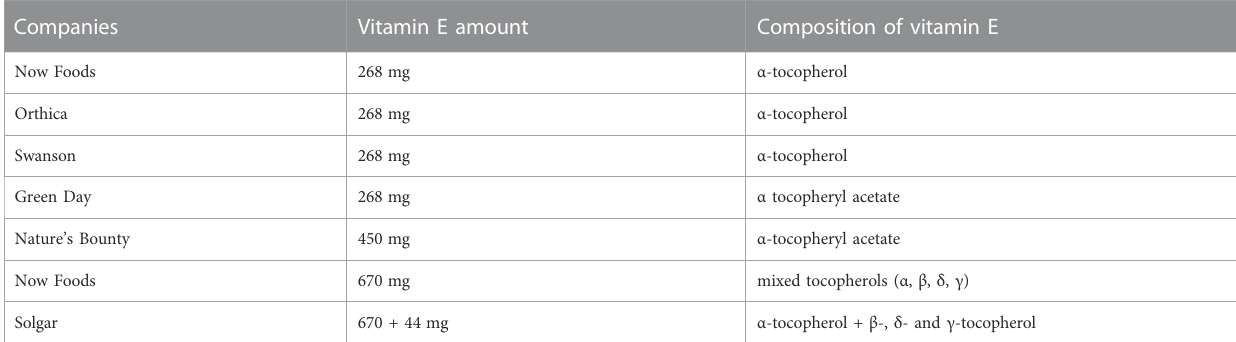
TABLE 1 Summary of available vitamin E formulations and vitamin E composition.